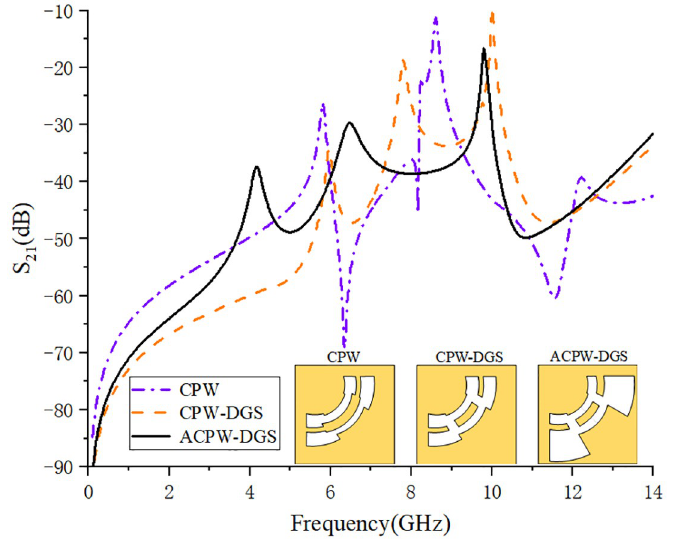
Fig 7. Comparison of weak coupling curves under different